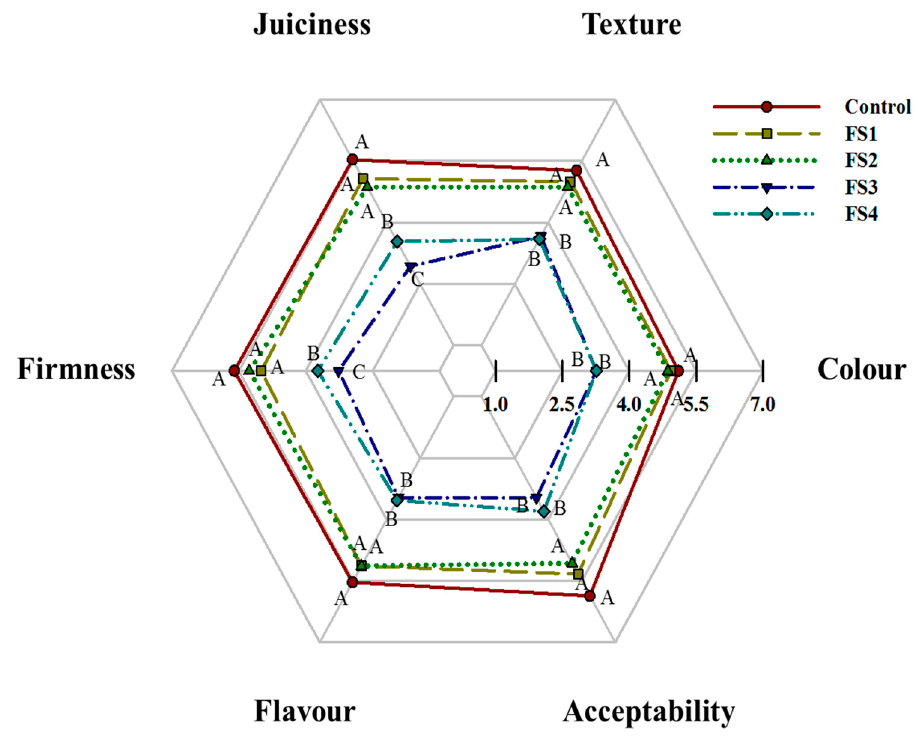
Figure 4. Sensory evaluation of the Harbin dry sausages with different replacement levels of CFS after fermentation. Control: 100% backfat; FS1: 80% backfat and 20% CFS; FS2: 60% backfat and 40% CFS; FS3: 40% backfat and 60% CFS; FS4: 20% backfat and 80% CFS. Different uppercase letters (A–C) mean significant differences among the treatments ( p < 0.05).